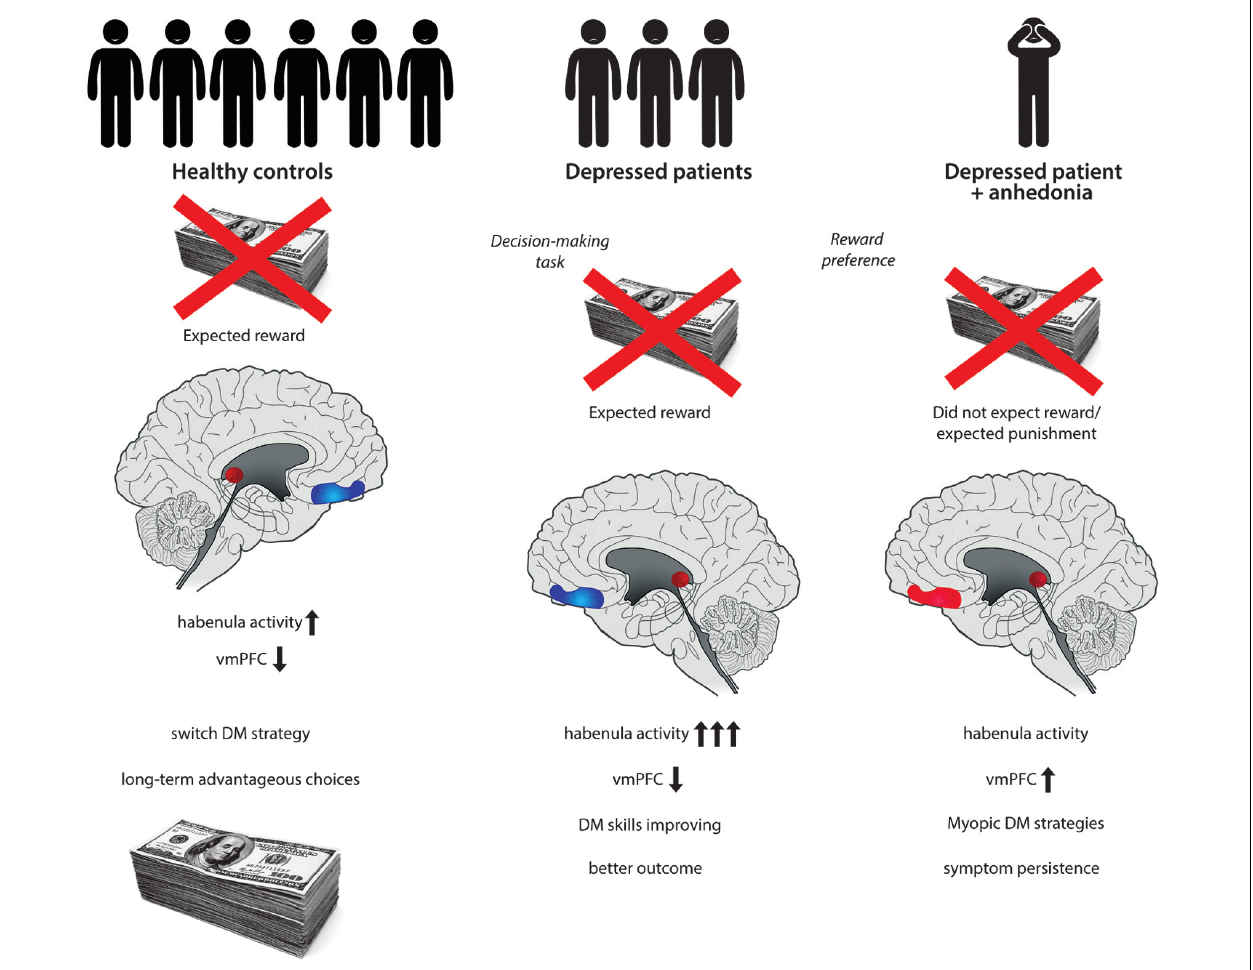
FIGURE 1 |After encountering a large penalty eventually exceeding an expected reward while playing the Iowa Gambling Task (IGT), healthy control participants tend to switch strategy. The absence of an expected reward is associated with habenula activation and subsequent decrease in ventromedial prefrontal cortex (vmPFC) activity. Adequate integration of reinforcement history favors long-term advantageous decision-making (DM). Depressed patients might be influenced by immediate reinforcers, such as high rewards during a DM task